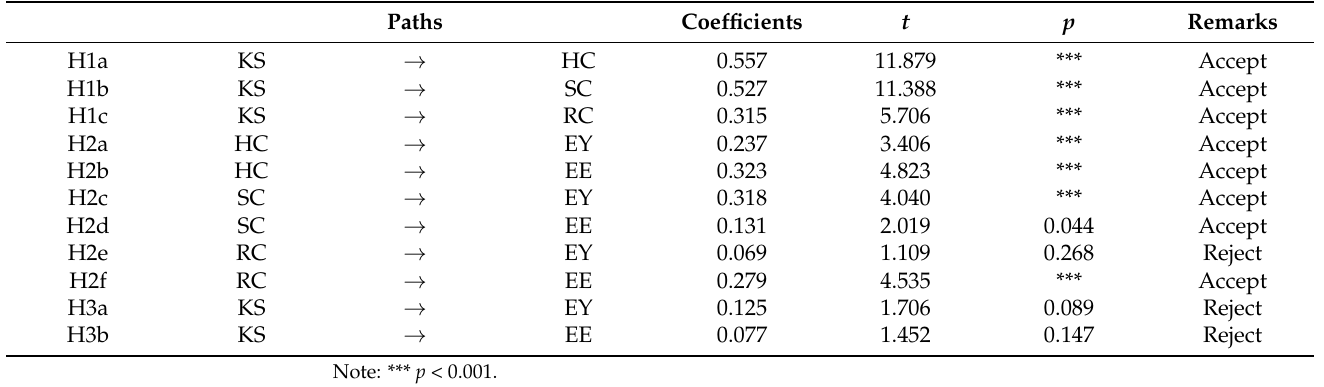
Table 5. Standardized path coefficients.